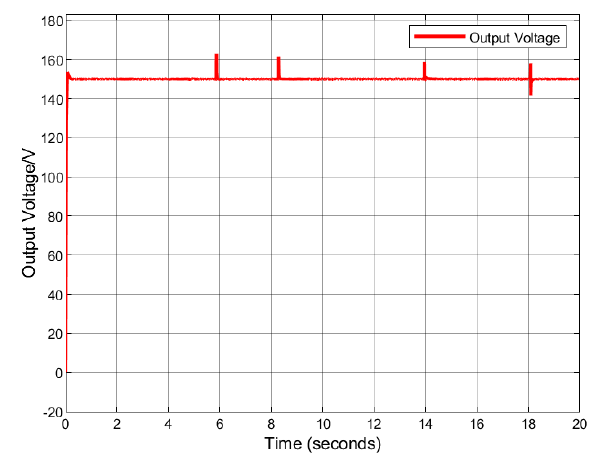
Figure 17. Output voltage of the battery pack.